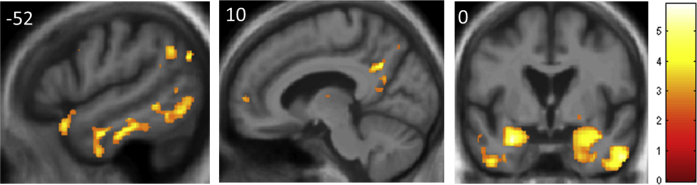
Distribution of gray matter atrophy in the Alzheimer's disease group. Statistical parametric maps of regional gray matter atrophy in the Alzheimer's disease group compared to the healthy control group from the voxel-based morphometry analysis are shown. Maps are presented on a group mean T1-weighted MR image in MNI space, thresholded leniently for display purposes at p < 0.01 uncorrected for multiple voxel-wise comparisons over the whole brain. The color side bar codes voxel-wise t-values of gray matter change. Planes of representative sections are indicated using the corresponding MNI coordinates (mm); the right hemisphere is shown on the right in the coronal section. (For interpretation of the references to color in this figure legend, the reader is referred to the Web version of this article.)